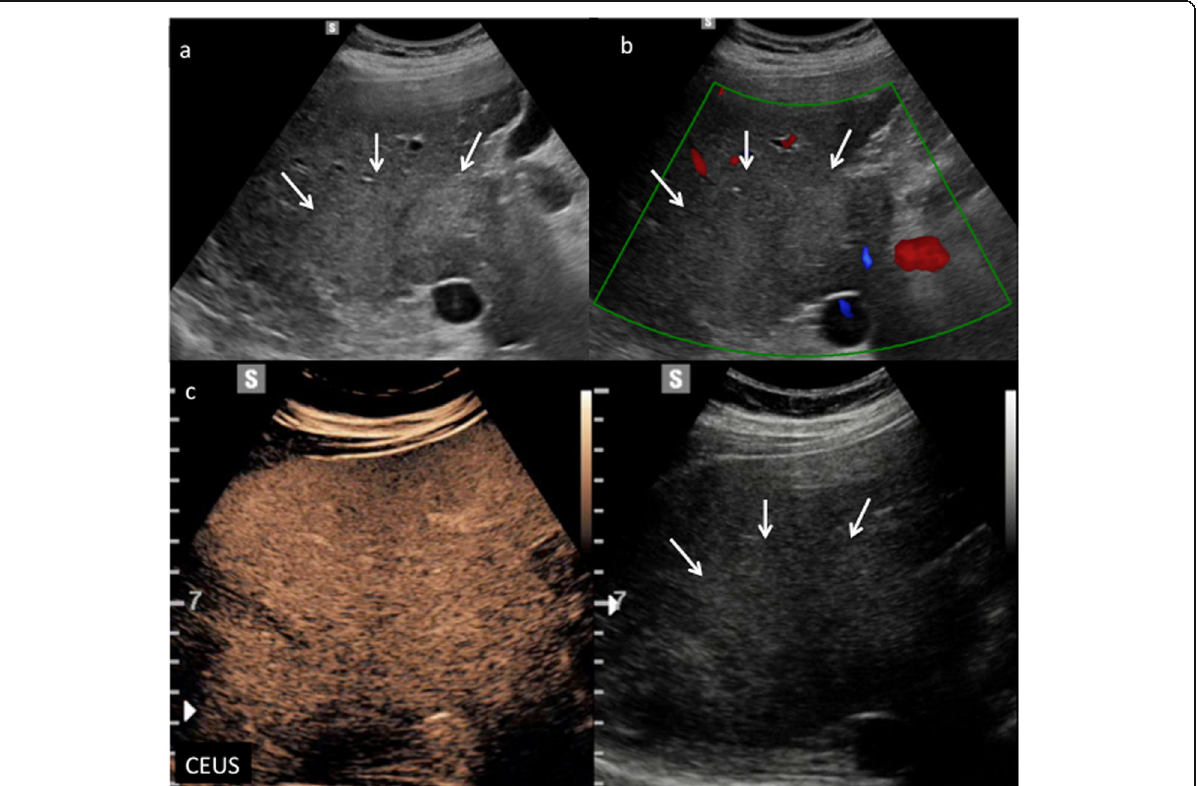
Fig. 6 CEUS LI-RADS 2 (probably benign). Non mass-like area in a 57-year-old man with virus C-related cirrhosis. Baseline US image ( a ) shows a slightly hyperechoic area with indistinct margins sized 7 cm in the segment V – VI (arrows). The area does not show any vascular signal at color- Doppler ( b ) (arrows). At CEUS ( c ), it appears constantly isoechoic with respect to the surrounding liver parenchyma throughout the vascular study